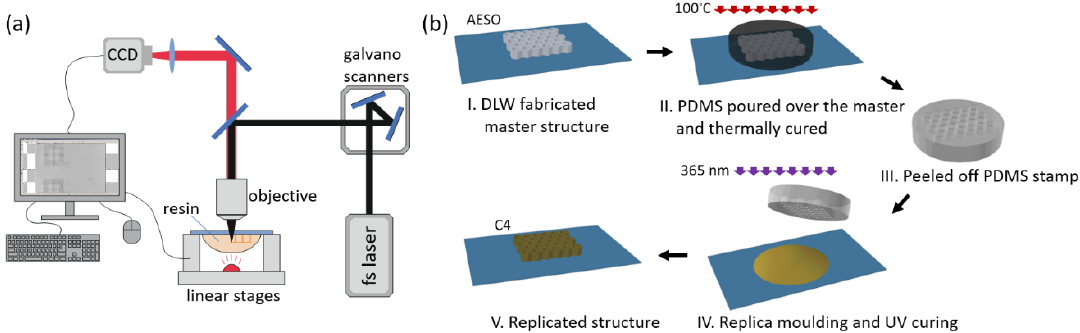
Figure 2. ( a ) Optical setup for direct laser writing (DLW) 3D lithography. ( b ) Steps of making the replica by the microtransfer molding (μTM) technique.